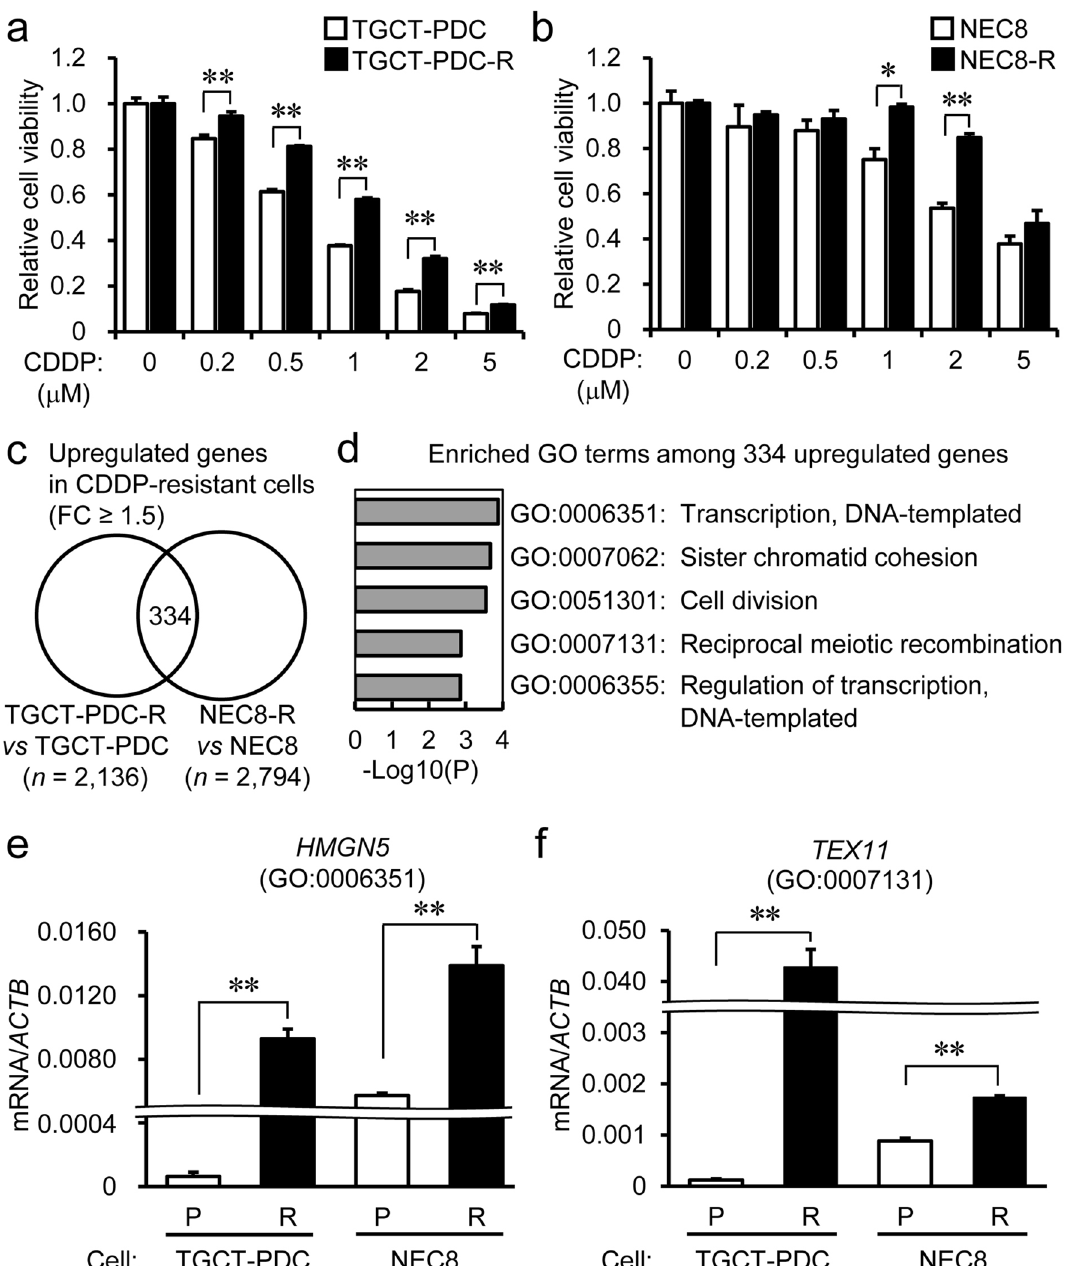
Figure 1. Generation of cisplatin-resistant testicular germ cell tumor (TGCT) cells and identification of upregulated genes in cisplatin-resistant TGCT cells versus parental cells. (a) Inhibitory effects of cisplatin to the viability of parental and cisplatin-resistant TGCT patient-derived cells (TGCT-PDC). Cells were treated with cisplatin at indicated concentrations for 96 h and subjected to the quantitation of intracellular ATP content. CDDP, cisplatin. TGCT-PDC-R, cisplatin-resistant TGCT-PDC. Results are shown as mean fold change ± SE of relative luciferase activity (n = 3). (b) Inhibitory effects of cisplatin to the viability of parental and cisplatin- resistant NEC8 cells. Cells were treated with cisplatin at indicated concentrations for 72 h and subjected to WST-8 cell proliferation assay. Results are shown as mean fold change ± SE of relative absorbance at 450 nm wavelength (n = 5). NEC-R, cisplatin-resistant NEC8 cells. (c) Microarray analysis identified 334 overlapping genes commonly upregulated by ≥ 1.5 fold with a fluorescence signal ≥ 5 in cisplatin-resistant cells compared to the corresponding parental cells. (d) Top 5 signaling pathways enriched among the 334 commonly upregulated genes in cisplatin-resistant TGCT-PDC and NEC8 cells based on Gene Ontology Term. (e,f) Overexpression of HMGN5 (e) and TEX11 (f) in cisplatin-resistant TGCT cells. P , parental cells. R, cisplatin-resistant cells. Results are shown as mean ± SE (n = 3). **, P <